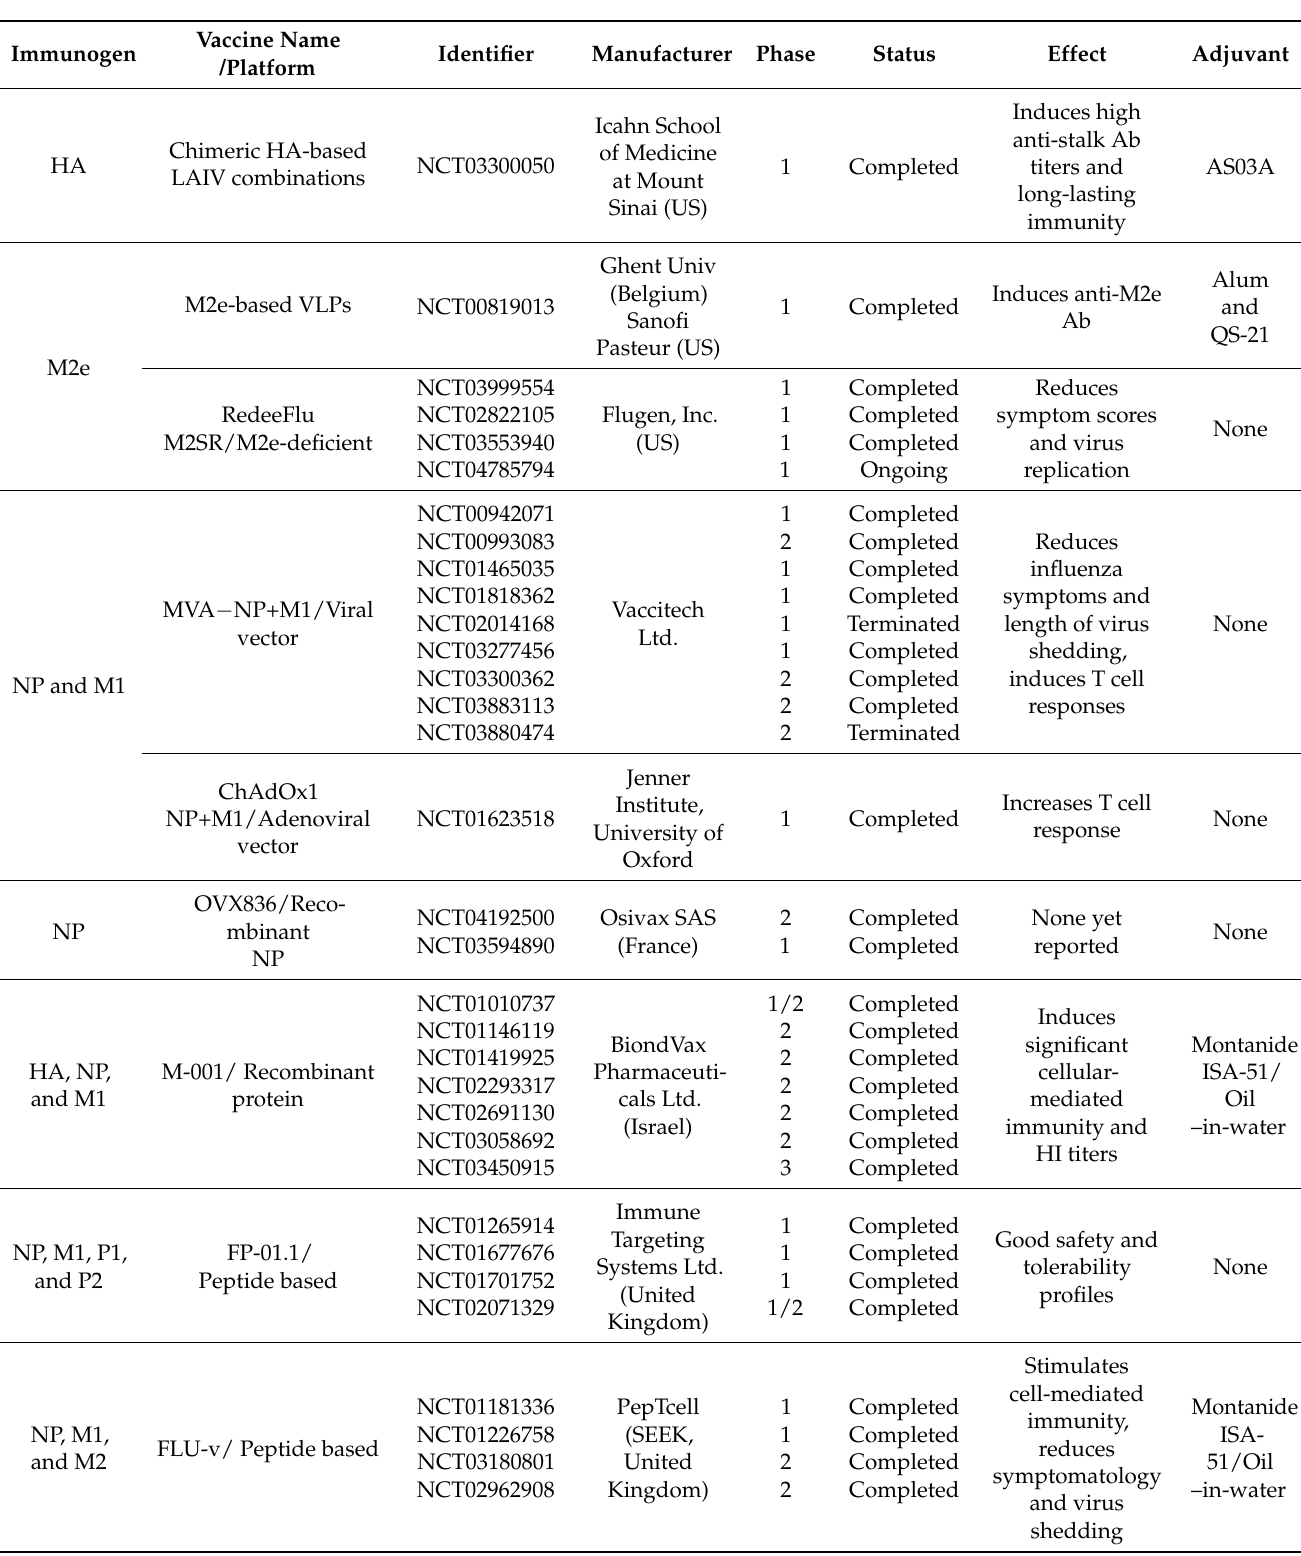
Table 1. Various universal Influenza vaccines in clinical